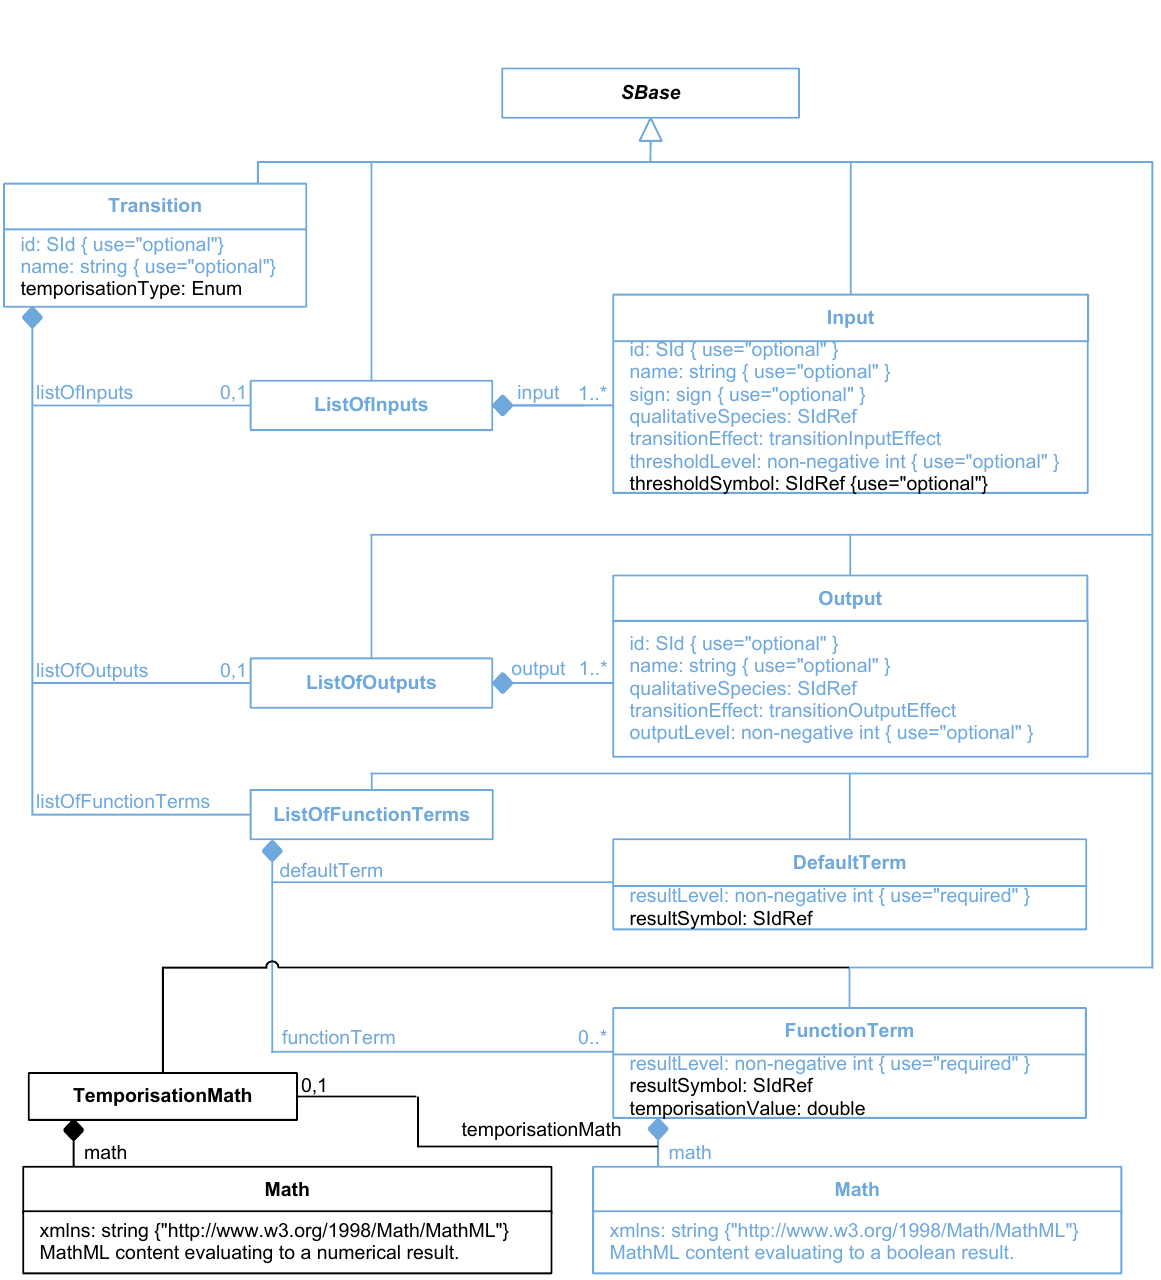
Figure 8: Possible future extensions of the Transition